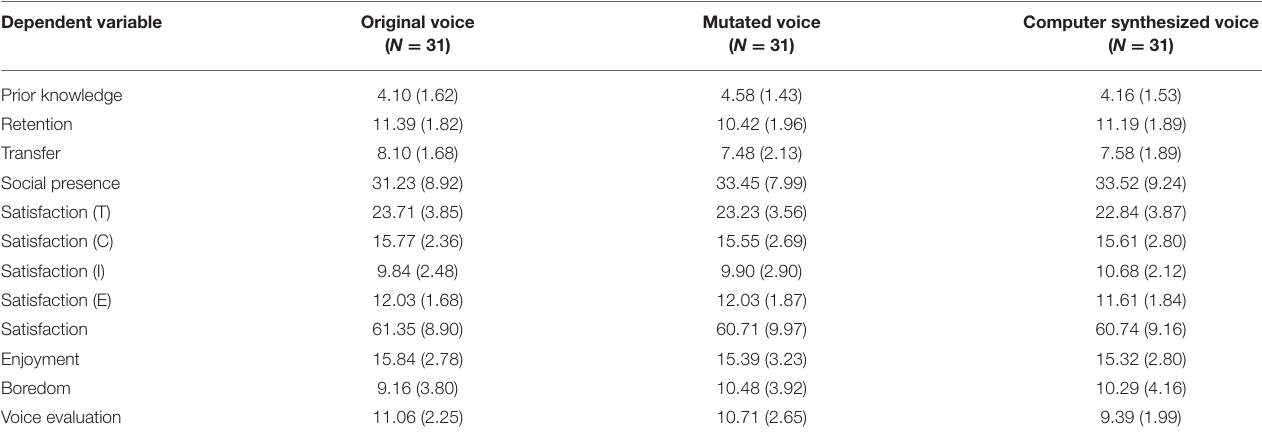
TABLE 2 | Means and standard deviations of all dependent variables for each condition in the voice